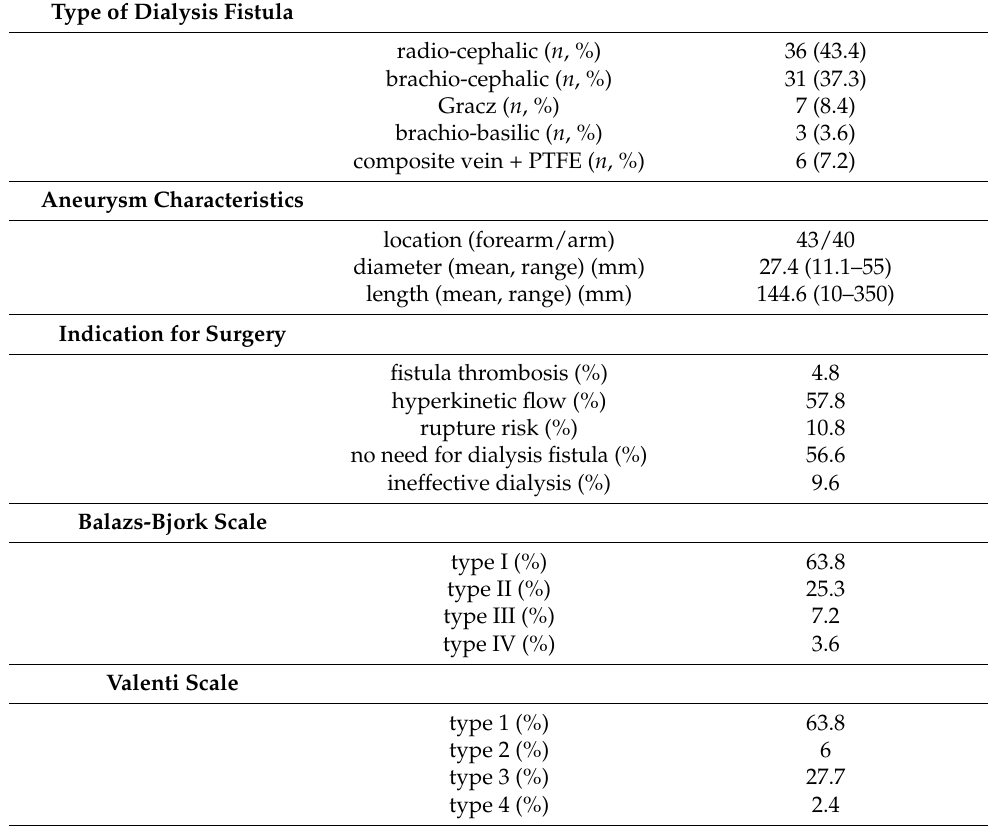
Table 2. Dialysis fistula aneurysm